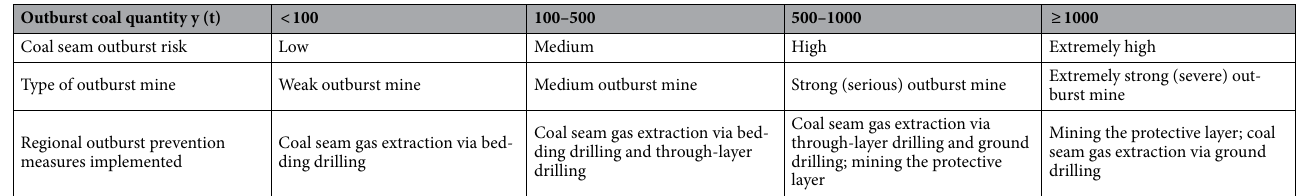
Table 3. Types of outburst mines and outburst prevention